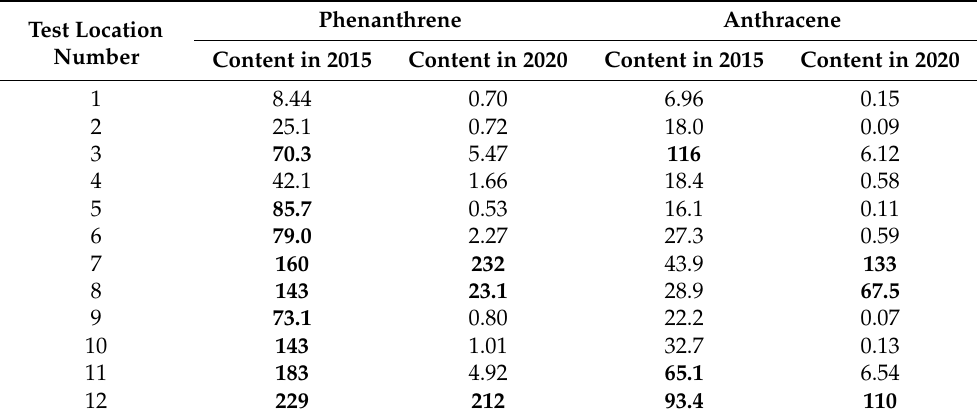
Table 4. Changes in phenanthrene and anthracene content (mg kg − 1 DM) in the soil before (2015) and after enhanced natural attenuation (2020).